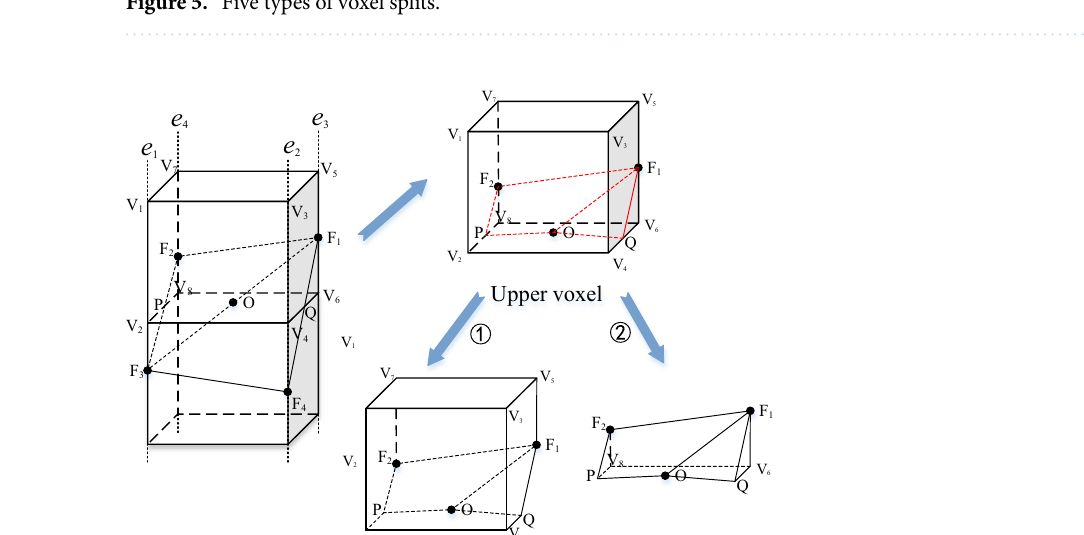
Figure 5. Five types of voxel splits.